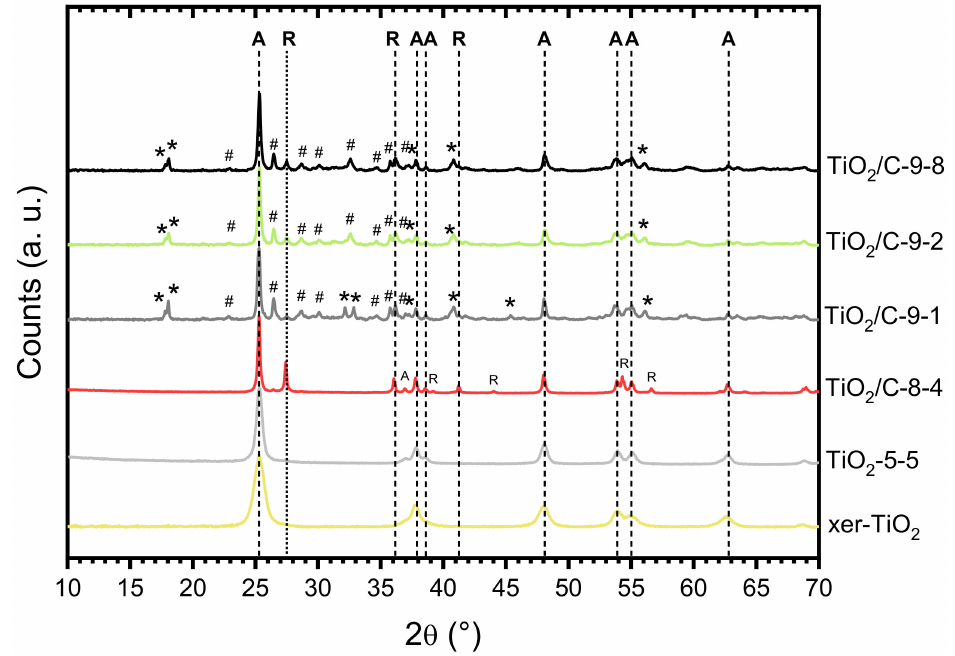
Figure 4. X-ray di ff raction (XRD) patterns of xer-TiO 2 , TiO 2 -5-5, and the TiO 2 / C- x - y series. A: Anatase; R: Rutile; ∗ : Ti 3 O 5 (monoclinic); #: Ti 6 O